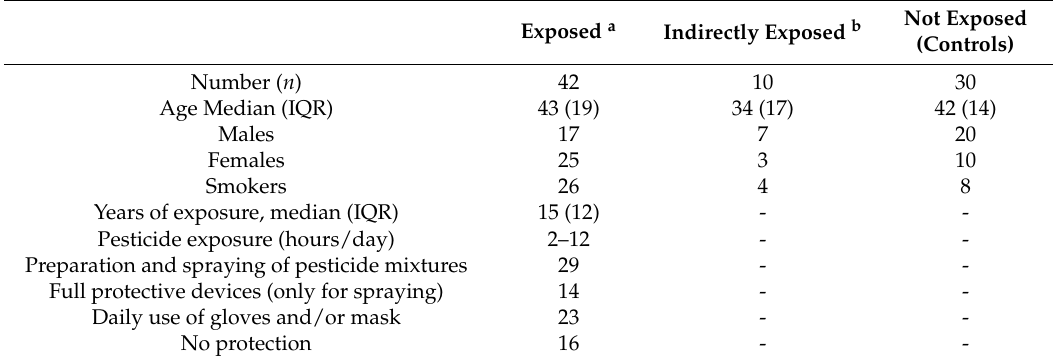
Table 1. General features of enrolled population and